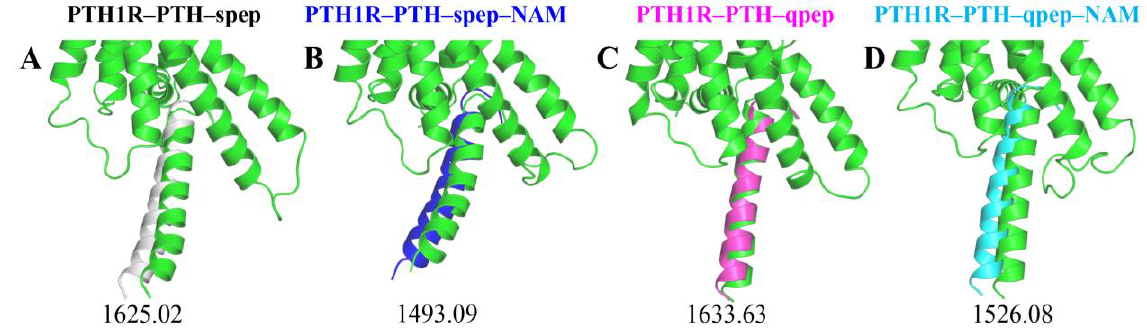
Figure 5. Free energy profiles with error bars from SMD simulations for PTH dissociation of each system.